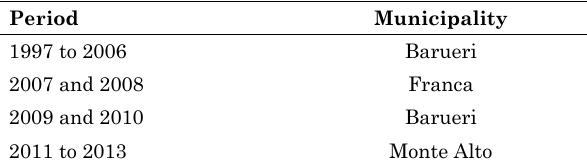
table 3. sewage treatment plants that provided sewage sludge for the experiment